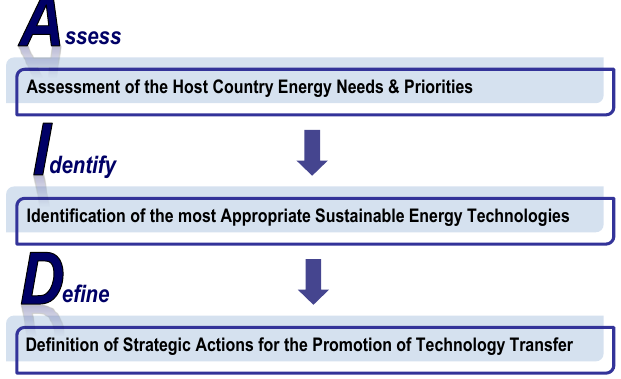
Figure 1. The assess-identify-define (AID) approach.